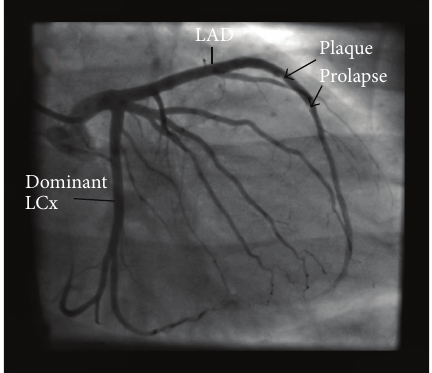
Figure 3: Postintervention angiographic image showing plaque prolapse. LAD: left anterior descending coronary artery; LCx: left circumflex coronary